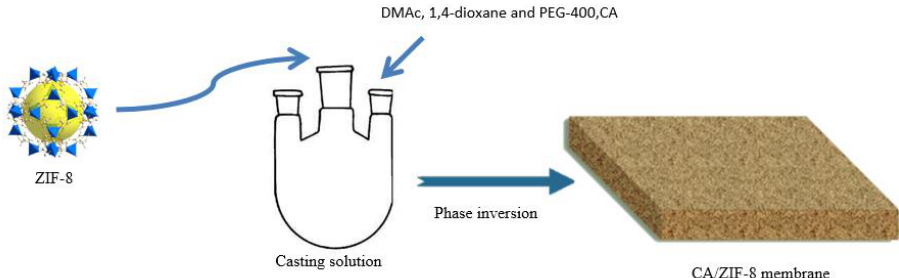
Figure 1. CA/ZIF-8 membrane preparation process.